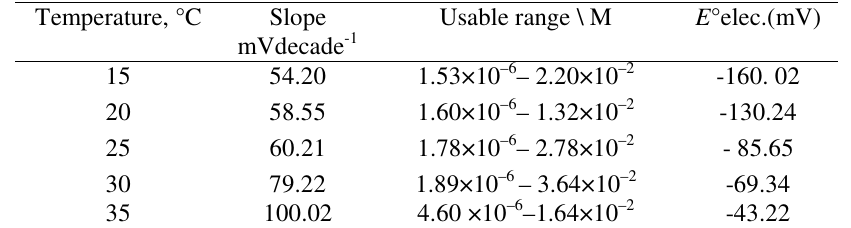
Table 5 . Performance characteristics of RTH-selective electrode at different temperatures .